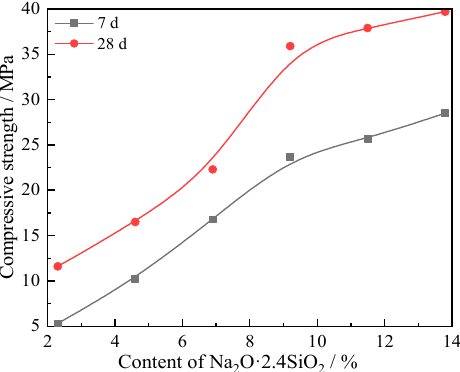
Figure 6. Cement paste compressive strength of composite alkali-activated cementitious material.